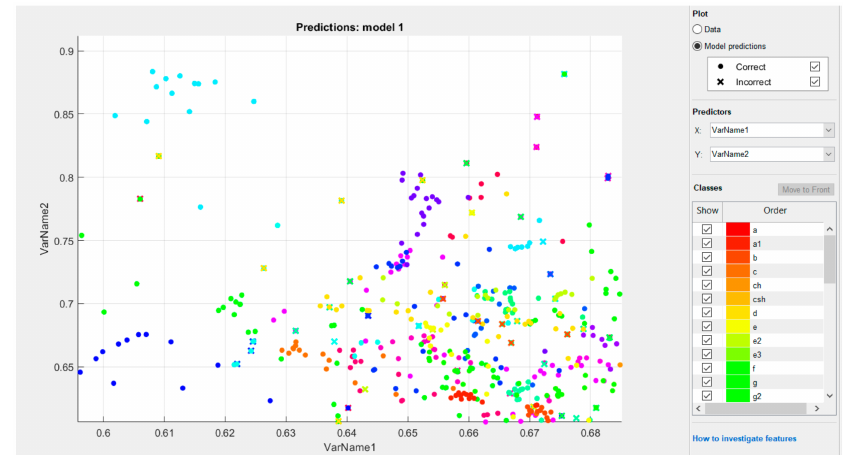
Figure 15. The result of the classification of the Kazakh dactylic